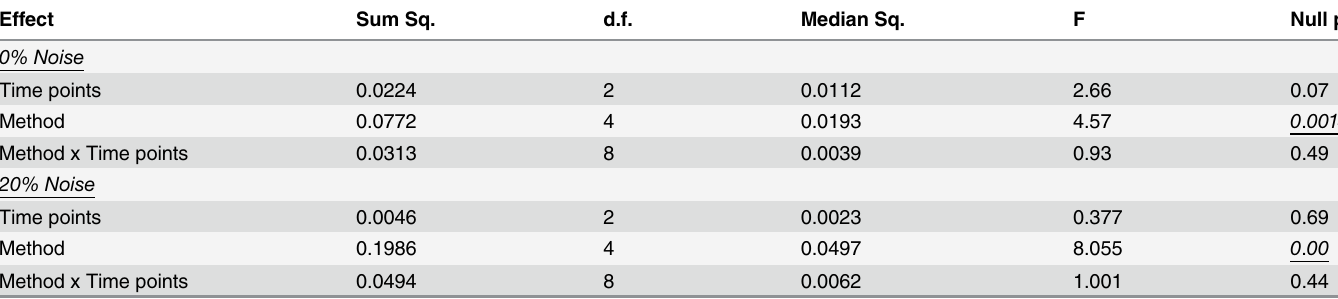
Table 1. Impact of sample size, experimental noise and algorithm selection on network